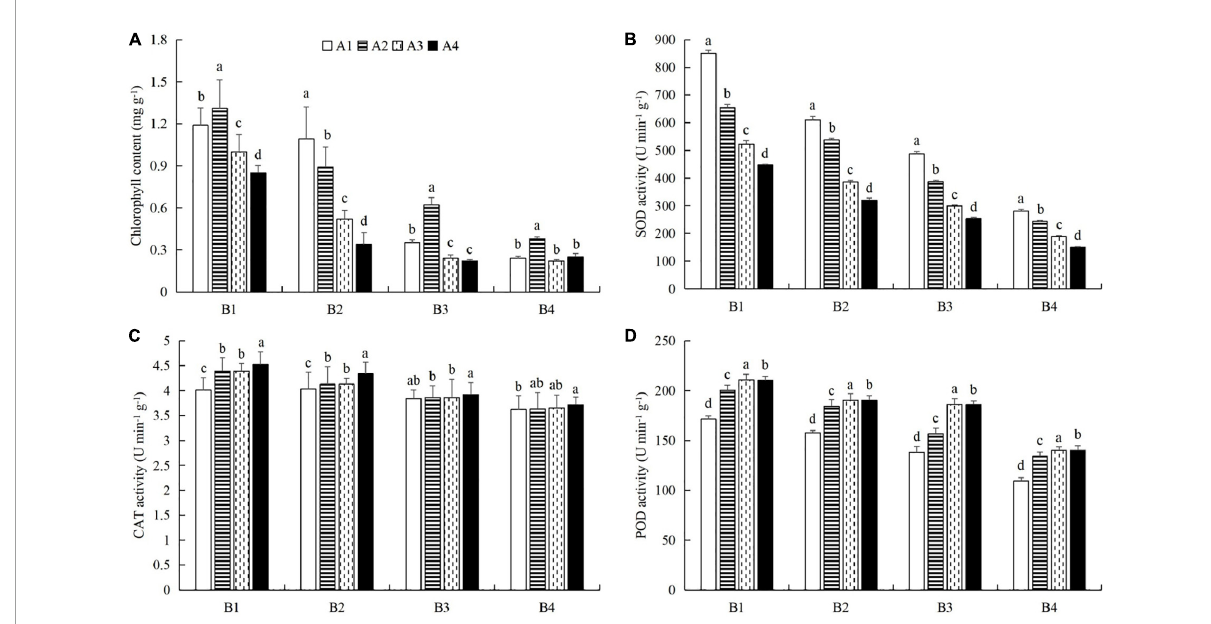
FIGURE11 The effects of azoxystrobin on (A) chlorophyll content and the activities of (B) superoxide dismutase (SOD), (C) catalase (CAT), and (D) peroxidase (POD) in cucumber leaves at different imidacloprid concentrations. Azoxystrobin concentrations: 4 mg L − 1 (A1), 2 mg L − 1 (A2), 1 mg L − 1 (A3), and 0 mg L − 1 (A4). Imidacloprid concentrations: 750 mg L − 1 (B1), 500 mg L − 1 (B2), 250 mg L − 1 (B3), and 0 mg L − 1 (A4). The mean value ± p < 0.05 error bar data were presented in the figure and different alphabetical letters indicate the significant differences between the different azoxystrobin concentrations.